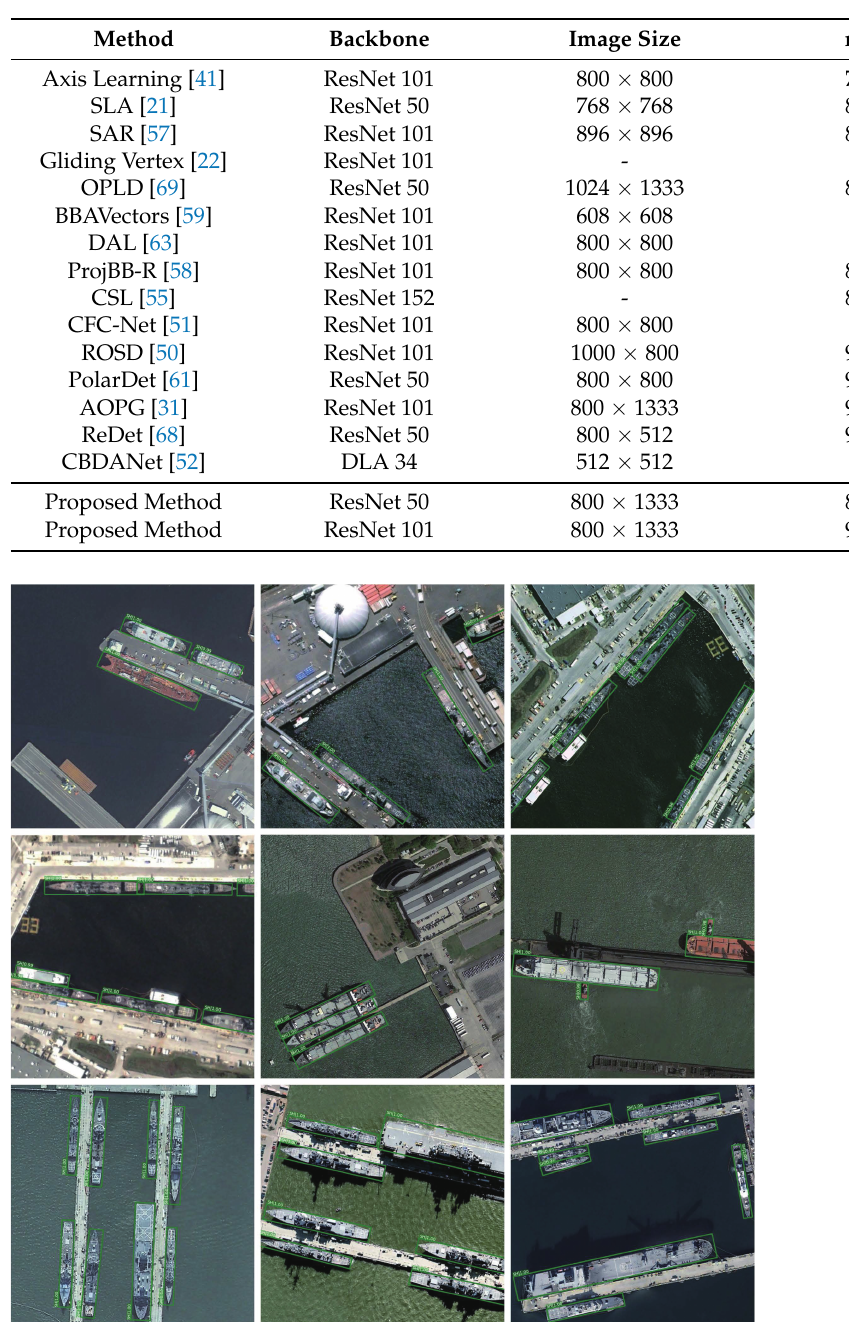
Table 3. Comparisons with other methods on HRSC2016 dataset test set. Bold denotes the best detection results.